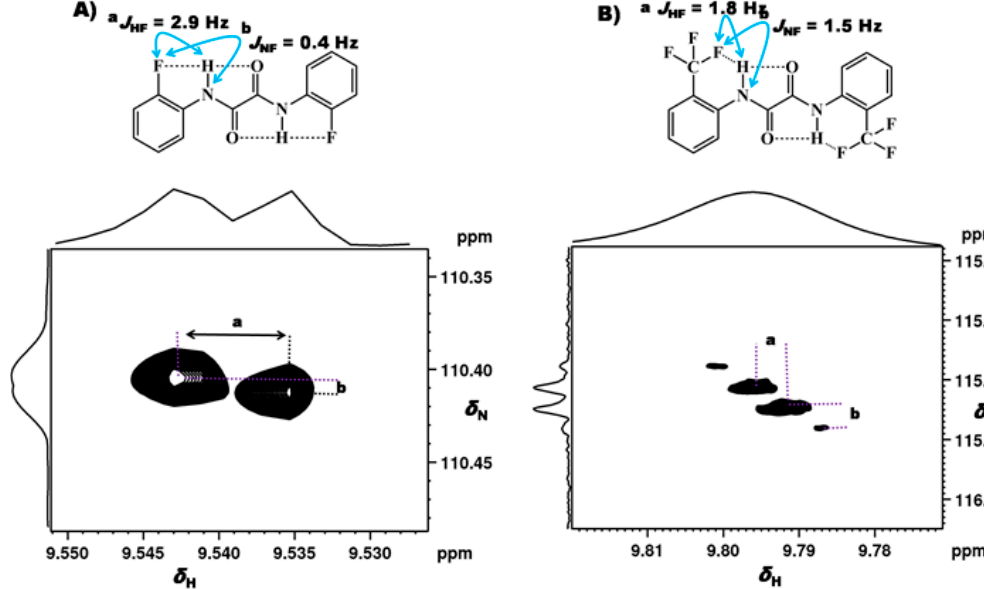
Figure 35. ( A , B ) 15 N- 1 H-HSQC spectra of the molecules 34 and 38 respectively, in CDCl 3 . The molecular structures and the measured couplings have also been reported.